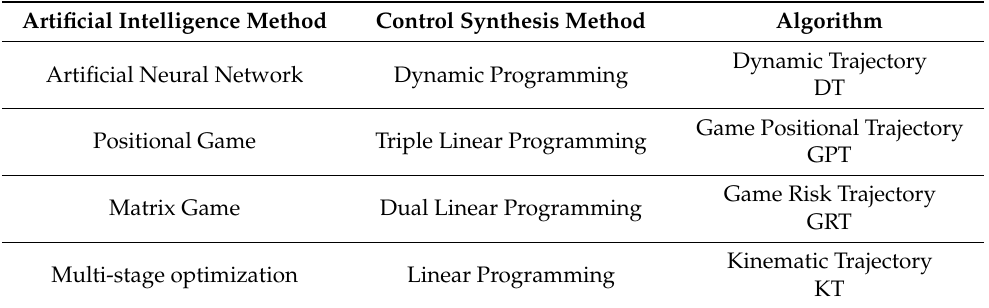
Table 1. Types of algorithms for determining the ship’s safe trajectory in a collision situation at sea. Artificial Intelligence Method Control Synthesis Method Algorithm Artificial Neural